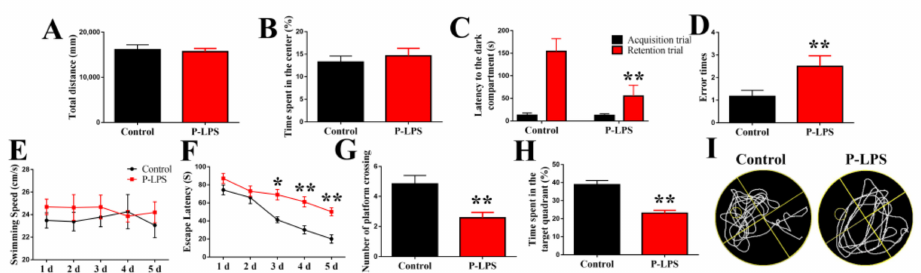
Figure 2. Effects of P. gingivalis LPS on the behaviors of mice. Total distance ( A ) and time spent in the center ( B ) were recorded in the OFT on the day 29 after P. gingivalis LPS. Latency to the dark compartment ( C ) and error times ( D ) were recorded on the days 36–37 after P. gingivalis LPS. Swimming speed ( E ), escape latency ( F ), number of platform crossing ( G ) and time spent in the target quadrant ( H ) were recorded in the MWM test. ( I ) MWM typological trajectories. All data are expressed as the mean ± SEM ( n = 12 per group). * p < 0.05 and ** p < 0.01 vs. the control